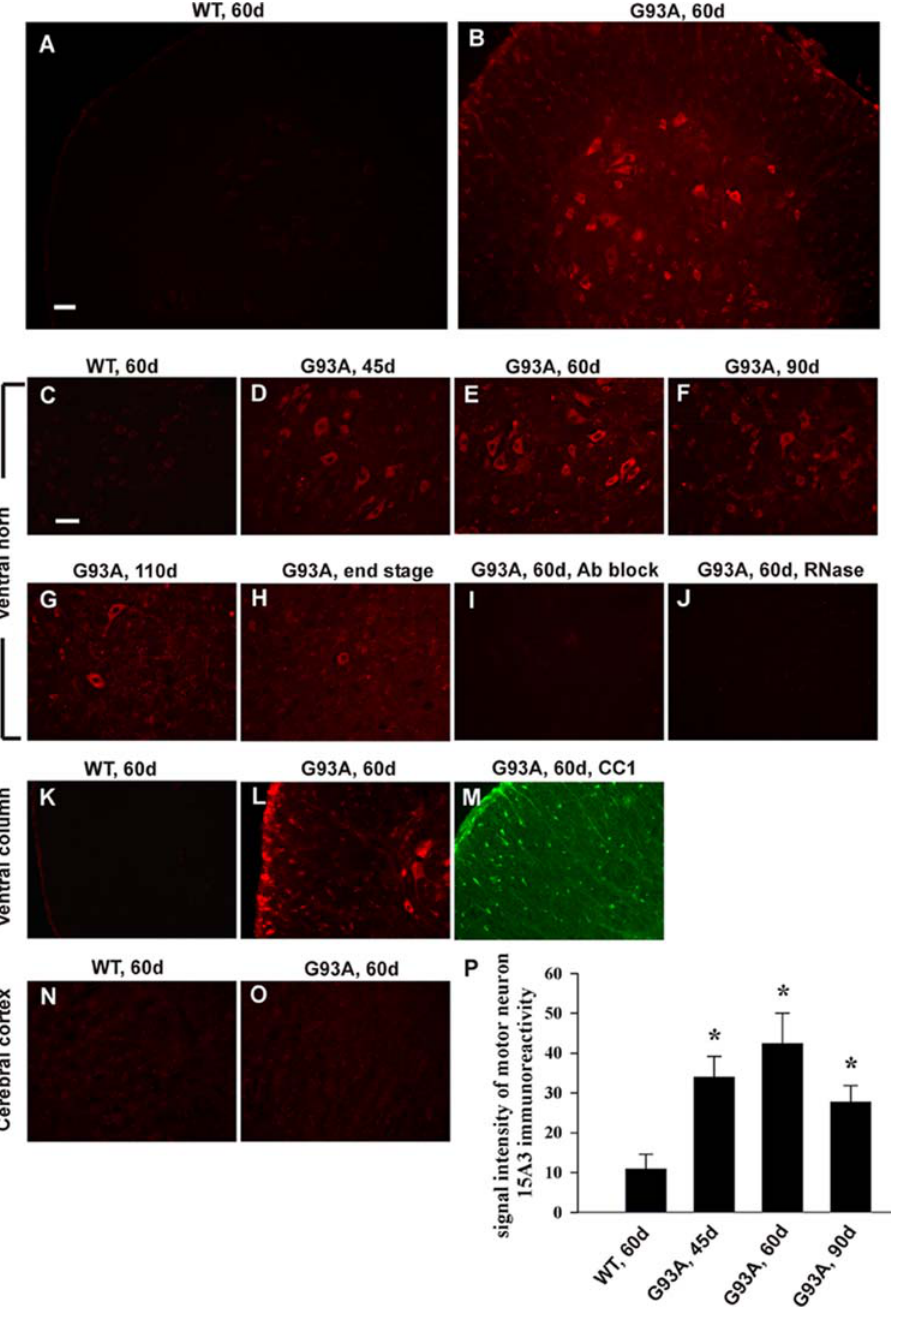
Figure 2. Increased RNA oxidation in motor neurons and oligodendrocytes of SOD1 G93A spinal cord at pre-symptomatic stage. Lumbar spinal cord sections from different ages of SOD1 G93A mice ( G93A ) and non-transgenic littermates ( WT ) were immunolabeled with 15A3 antibodies. The intensity of 15A3 immunofluorescence in SOD1 G93A mice was significantly increased at 45 days of age ( D ), further enhanced at 60 days of age ( B , E ), and then diminishes during the symptomatic stage ( F , G , H ), while only a very faint signal was detected in non-transgenic littermates ( A , C ). 15A3 immunoreactivity was prominent in the ventral horn motor neurons and the white matter oligodendrocytes ( K , L ), as identified by CC1 immunostaining ( M ). No increase of 15A3 immunofluorescence was observed in the brain sections ( N , O ). The immunoreactivity was diminished greatly by the RNase treatment ( J ) and when the antibody was pre-incubated with 8-OHG ( I ). Scale bar, 50 m m. ( P ) Statistical analysis of motor neuron 15A3 immunofluorescence intensity (n=20). Asterisks indicate statistical significance compared with WT, 60 d (* P , 0.0001). morphology by electron microscopy, and the results showed that observe ubiquitinated protein aggregation in motor neurons with strong 15A3 immunoreactivity at age of 60 days (Fig. 3C). These motor neurons with strong 15A3 immunoreactivity had only minor mitochondrial vacuolization (Fig. 3B). Ubiquitinated protein aggre- results indicate that those motor neurons showing RNA oxidation still gation is a hallmark of degenerating motor neurons. We did not appear to be healthy, and that RNA oxidation is an early event.